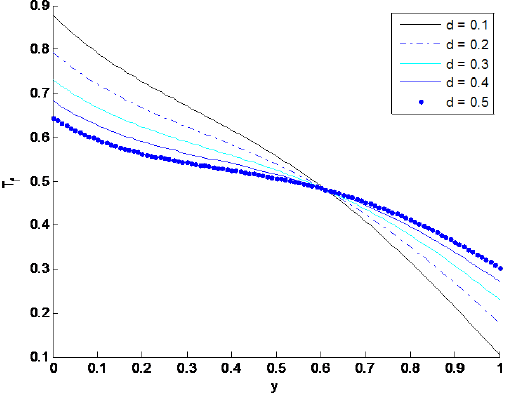
Figure 13: Temperature profile for different values of boundary thickness d ( Br = 0.2 , S = 0.4 , Gre = 50 , λ = −0.3 , ε = −0.3 , q = 1 )